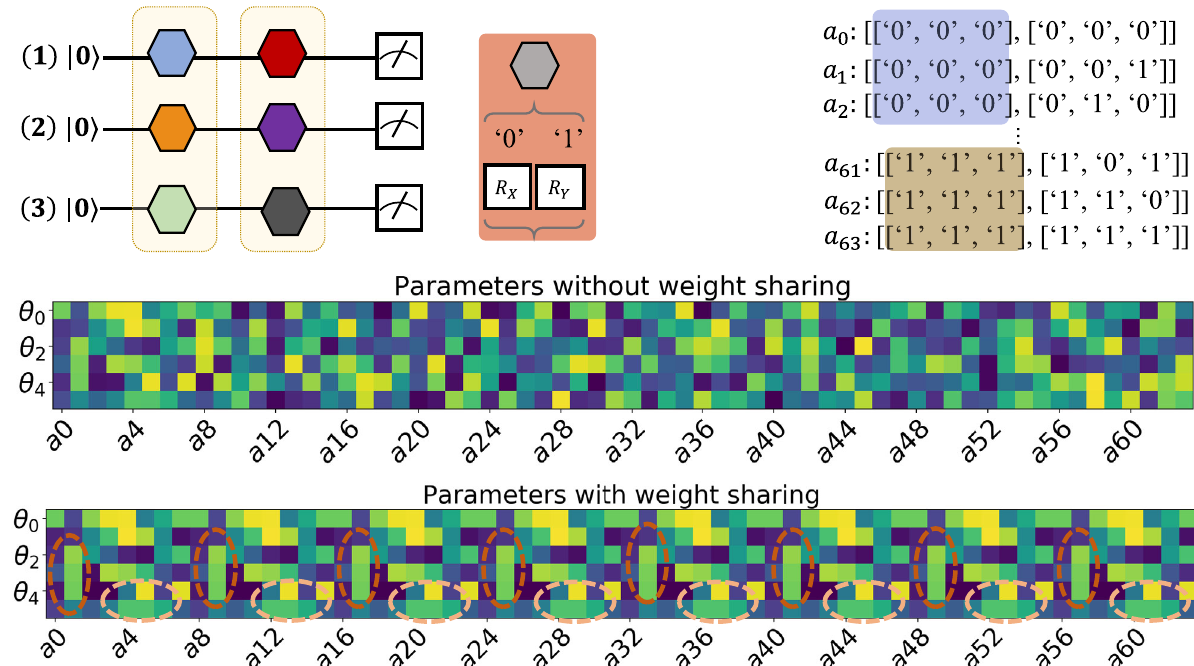
Fig. 4 A visualization of weight sharing strategy. The upper left panel depicts the potential ansatze when N = 3, L = 2, and the choices of quantum gates are { R X , R Y } with Q = 2. The total number of ansatze is Q NL = 64. The upper right panel illustrates how to use the indexing technique to accomplish the weight sharing. The label “ a i ” refers to the ansatz a ( i ) . Namely, for any two ansatze, if the indexes in the l th array are identical (highlighted by the blue and brown regions), then their trainable parameters in the l th layer are the same. The two heatmaps demonstrated in the lower panel visualize the trainable parameters of 64 ansatze. The label “ θ i ” refers to the parameter assigned to the i -th rotational quantum gate. Note that when the weight sharing strategy is applied, the trainable parameters are reused for different ansatze, as indicated by the dashed